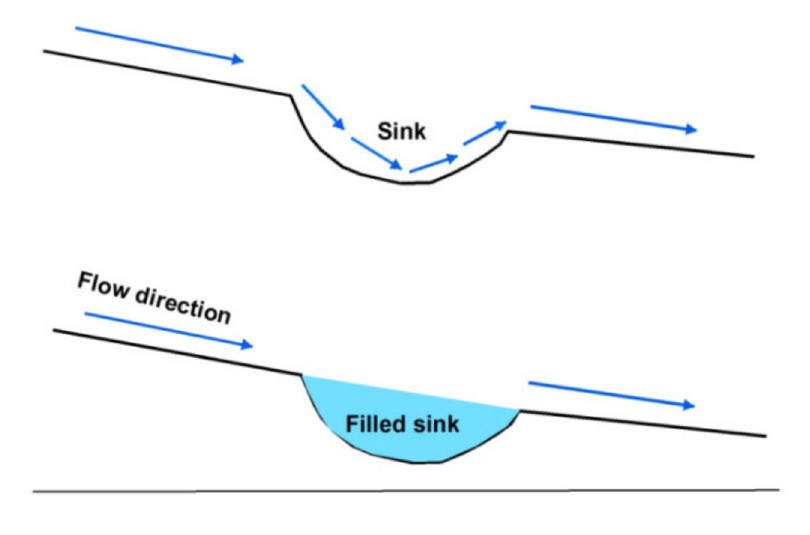
Figure 5. Illustration of the relationship between flow direction and